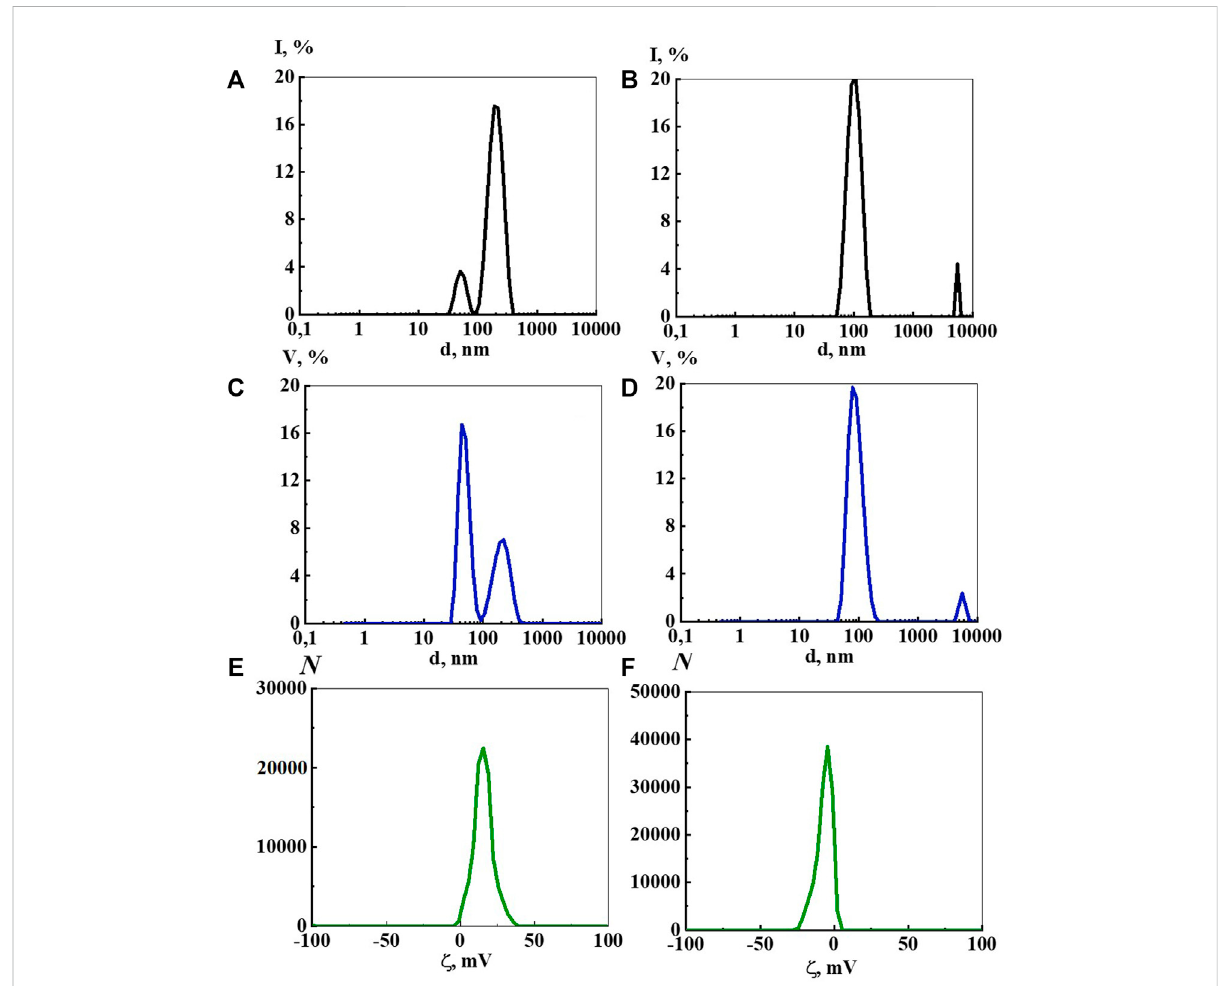
FIGURE 1 Particle size distribution based on light scattering intensity (A,B) and volume (C,D) , as well as ζ -potential (E,F) in the aqueous Dox systems at a concentration of 1 · 10 − 4 N (A,C,E) and 1 · 10 − 9 N (B,D,F) . Measurements were performed at 25 ± 0.1 °